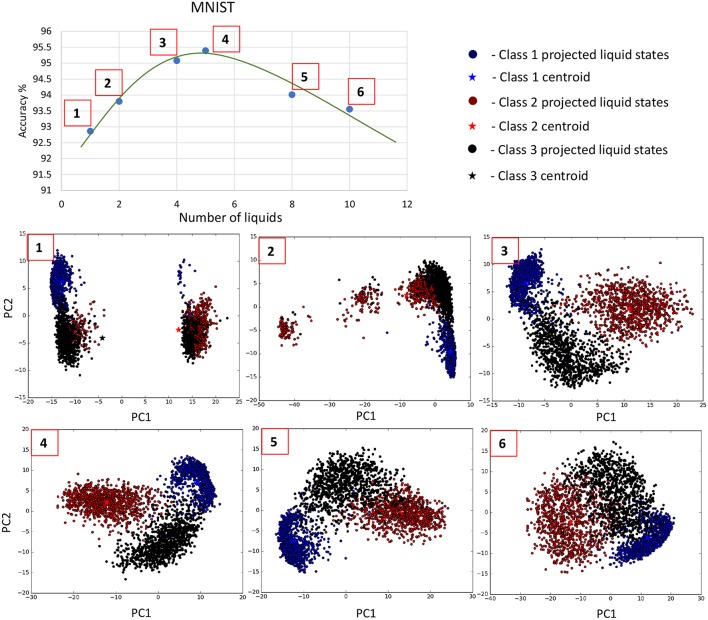
The distribution of the liquid state vectors, as a projection to the first two principal components PC1 and PC2, for different number of liquids. The liquid state vectors (represented as dots) correspond to three classes in the MNIST image data set. Each class has randomly picked 1, 000 liquid state vectors. Distributions related to point  and  show less overlapping between classes, and the data points are more concentrated at the class mean points in contrast to , which has significant overlapping that caused the accuracy degradation.